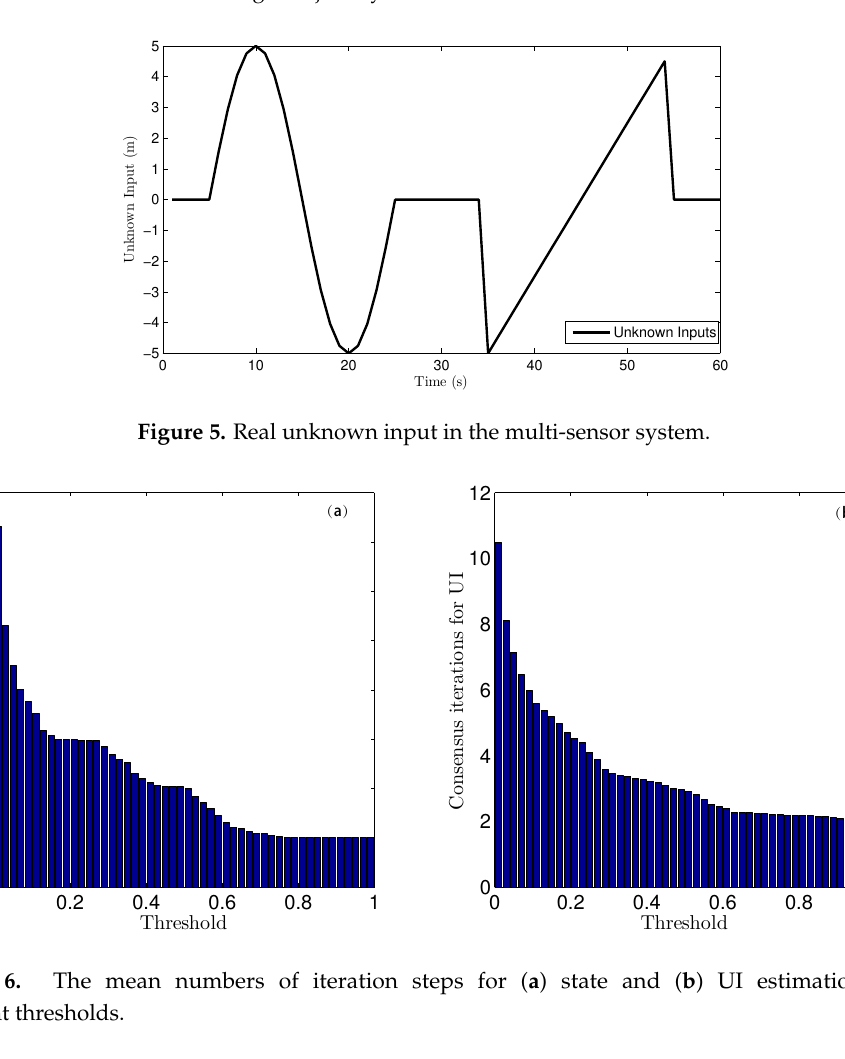
Figure 4. Examples of networks with 12 sensor nodes: ( a ) Graph-topological map of the network ( b ) Sensors’ real locations and target trajectory.